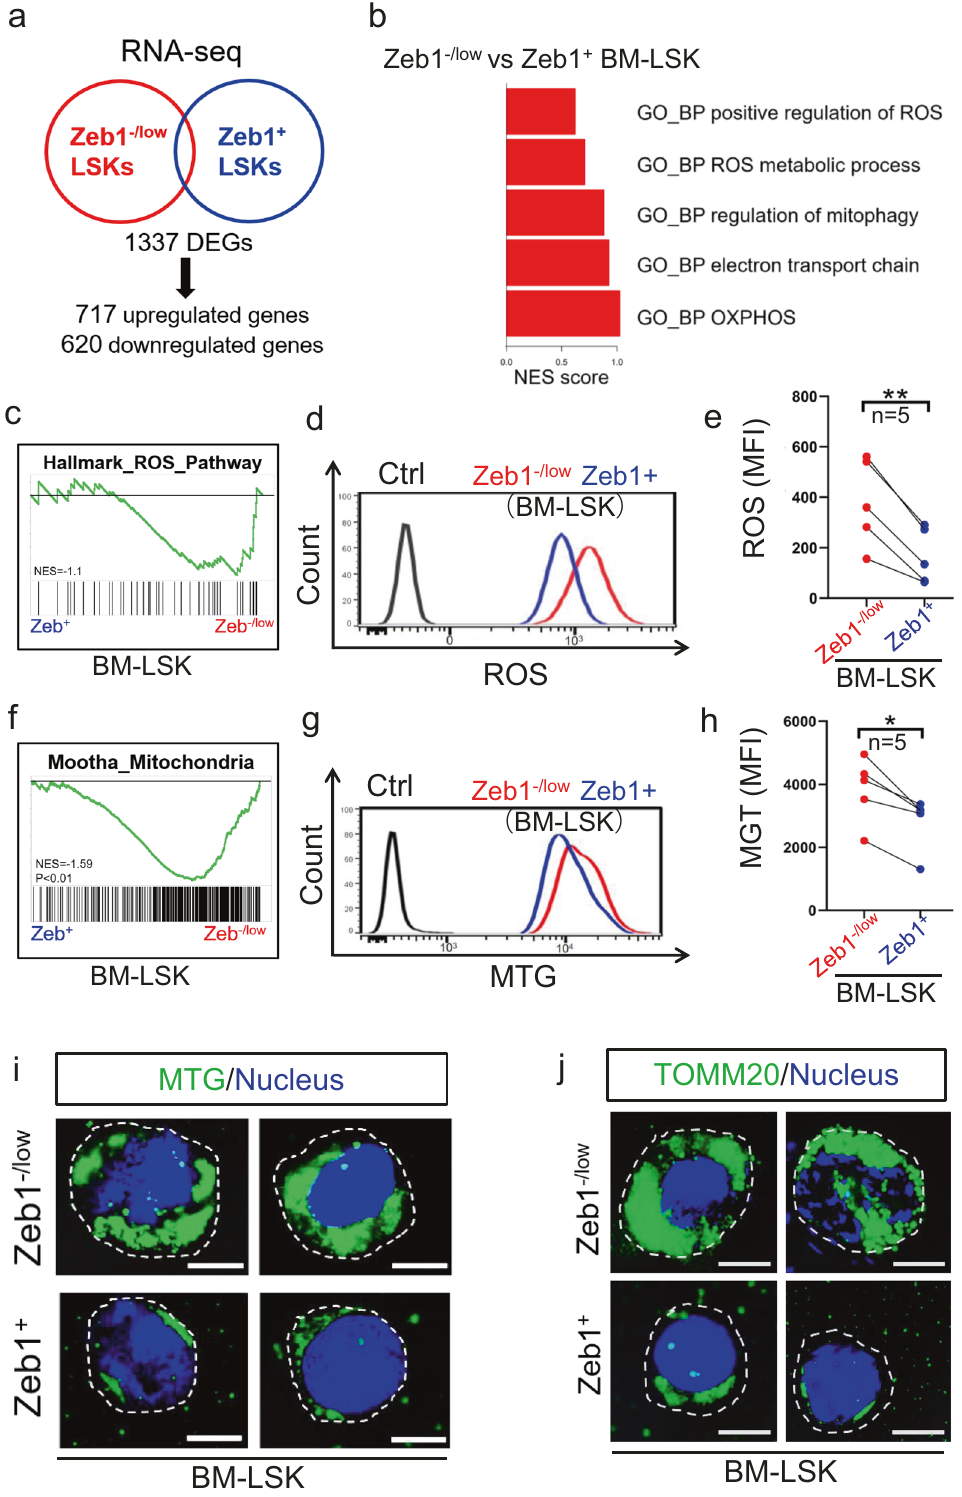
Zeb1 + -LSKs may explain why they have a lower amount of ROS than Zeb1 − /low -LSKs. As excessive ROS is detrimental to HSCs, we found that ROS scavengers, including superoxide dismutase ( Sod1/2 ) and catalase ( Cat ), were signi fi cantly higher in Zeb1 + - LSKs than those in Zeb1 − /low cells (Supplementary Fig. 3f, g),